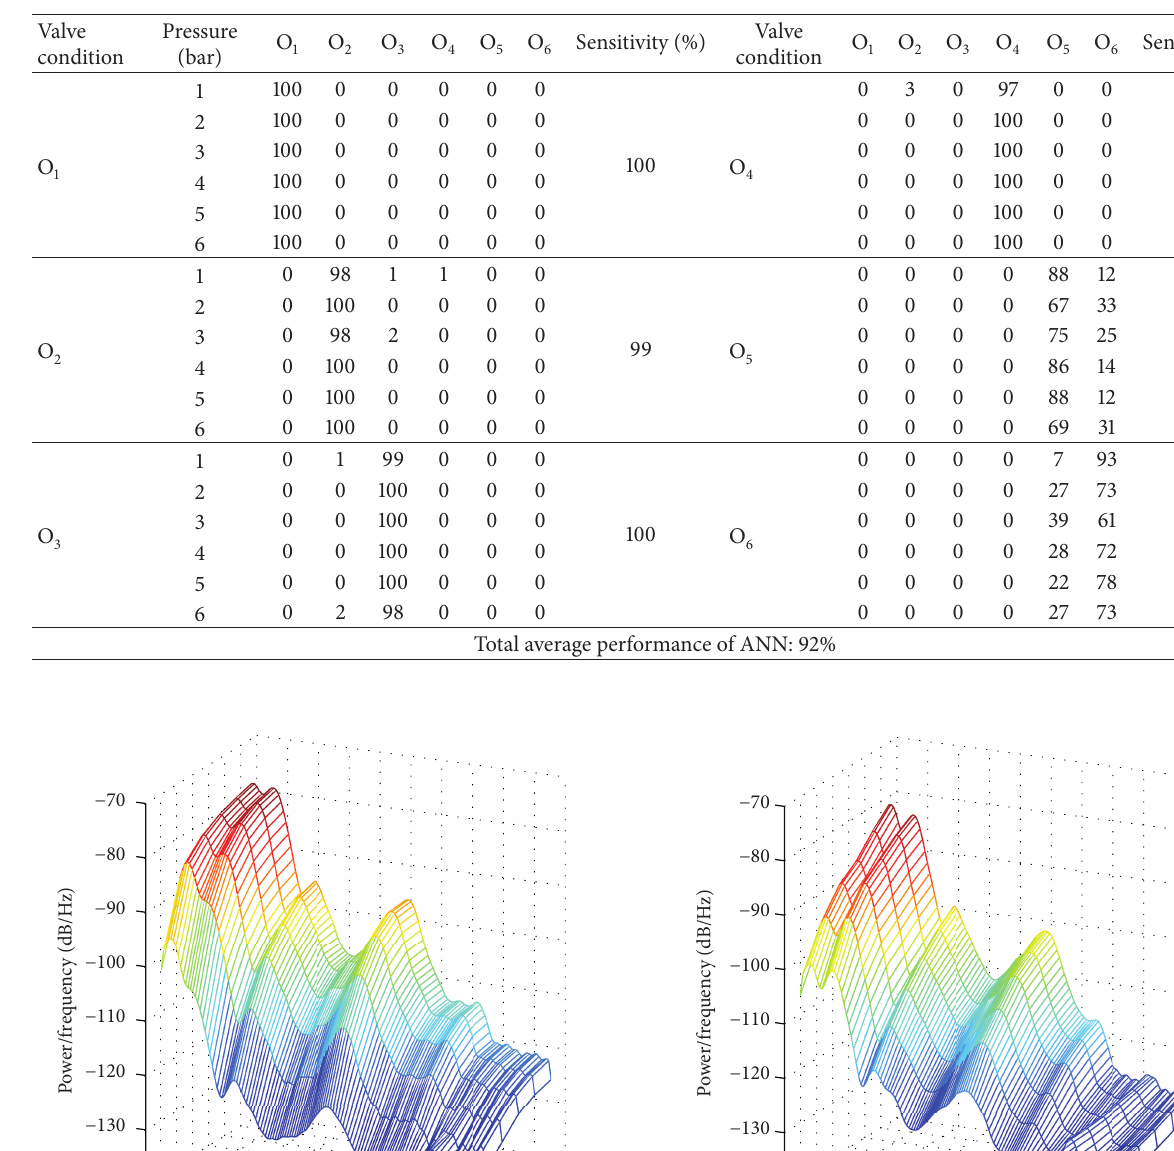
Table 2: Confusion matrix of testing data for ANN.